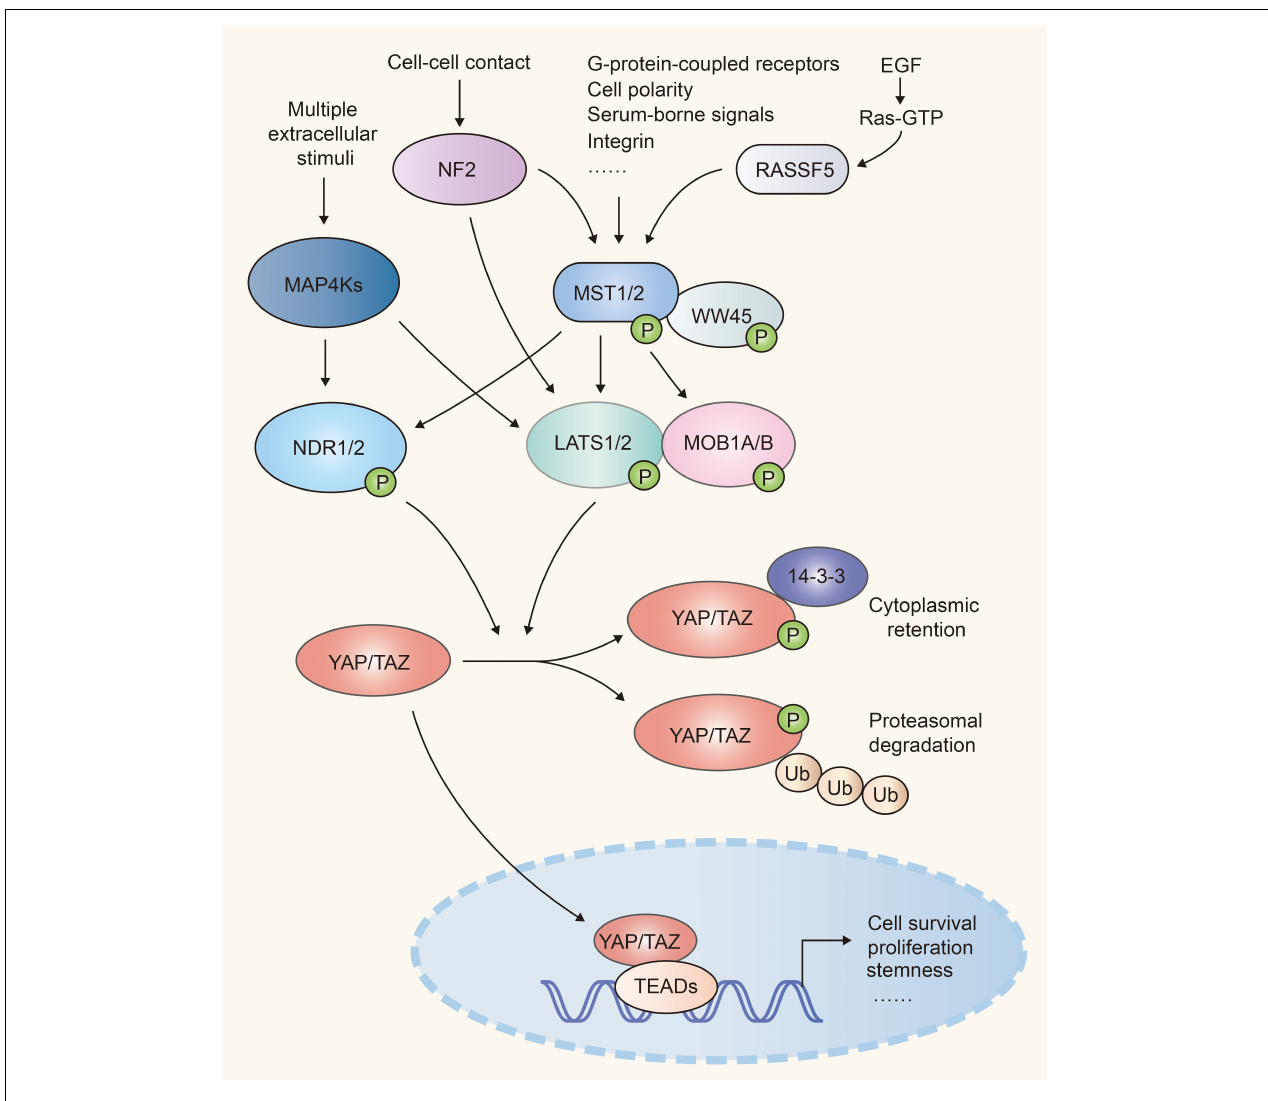
FIGURE 1 | A simple scheme of the Hippo pathway in mammalian cells. NF2 and RASSF family proteins (e.g. RASSF5) function upstream and facilitate the activation of Mst1/2. MST1/2 and MAP4Ks relay diversified extracellular and intracellular signals, and activate LATS1/2 and NDR1/2, which cause inhibitory phosphorylation of YAP/TAZ. When Hippo signaling is attenuated, activated YAP/TAZ translocate into nuclei and recruit TEAD transcription factors to regulate cell proliferation, survival, and